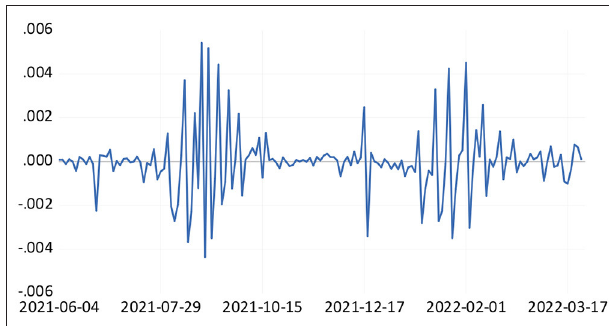
FIGURE 2 | MADEUR exchange rate after stationarity.